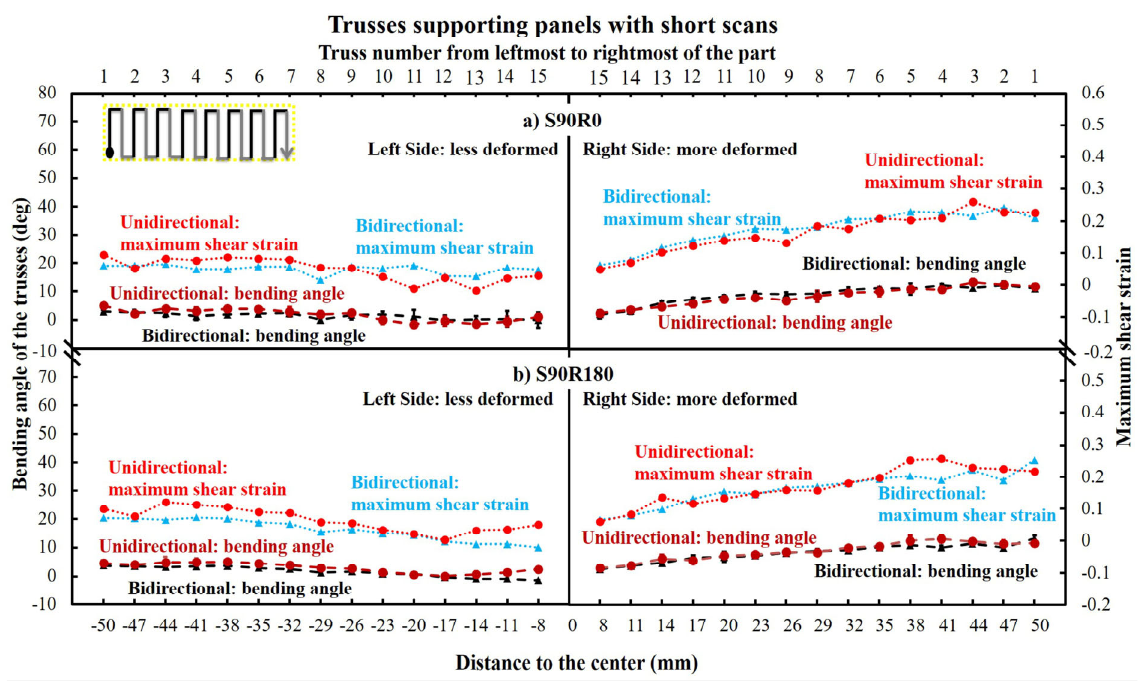
Figure 15. The bending angle and maximum shear strain (derived from maximum bending angle) for the supporting truss of the parts made with short ‐ Y scans. Note that the bending of the trusses from two sides of the central supporting block are not symmetric.